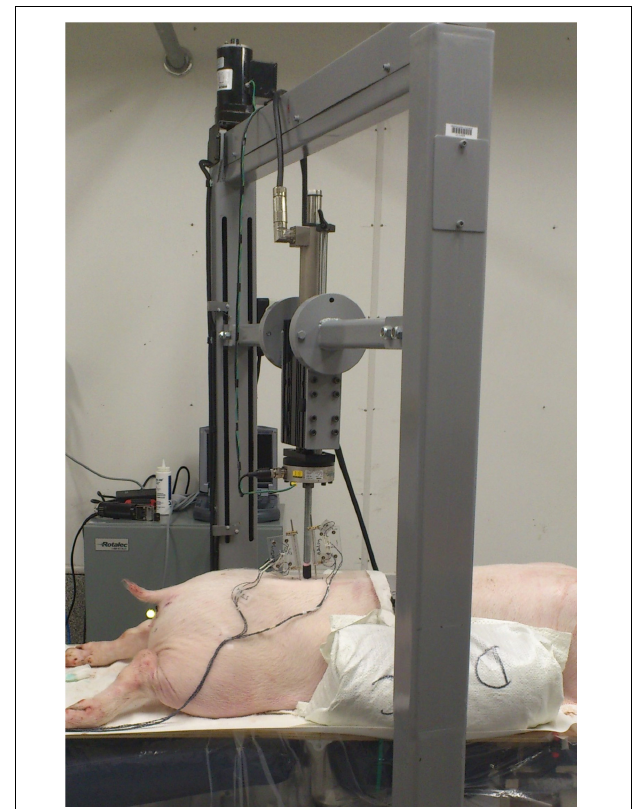
FIGURE 1 | Experimental set up: porcine cadaveric model with rectangular flags with four infrared light-emitting diode markers attached to bone pins drilled into L3 and L4 vertebrae and the mechanical device with a servo-controlled linear motor actuator to apply the standardized spinal manipulative